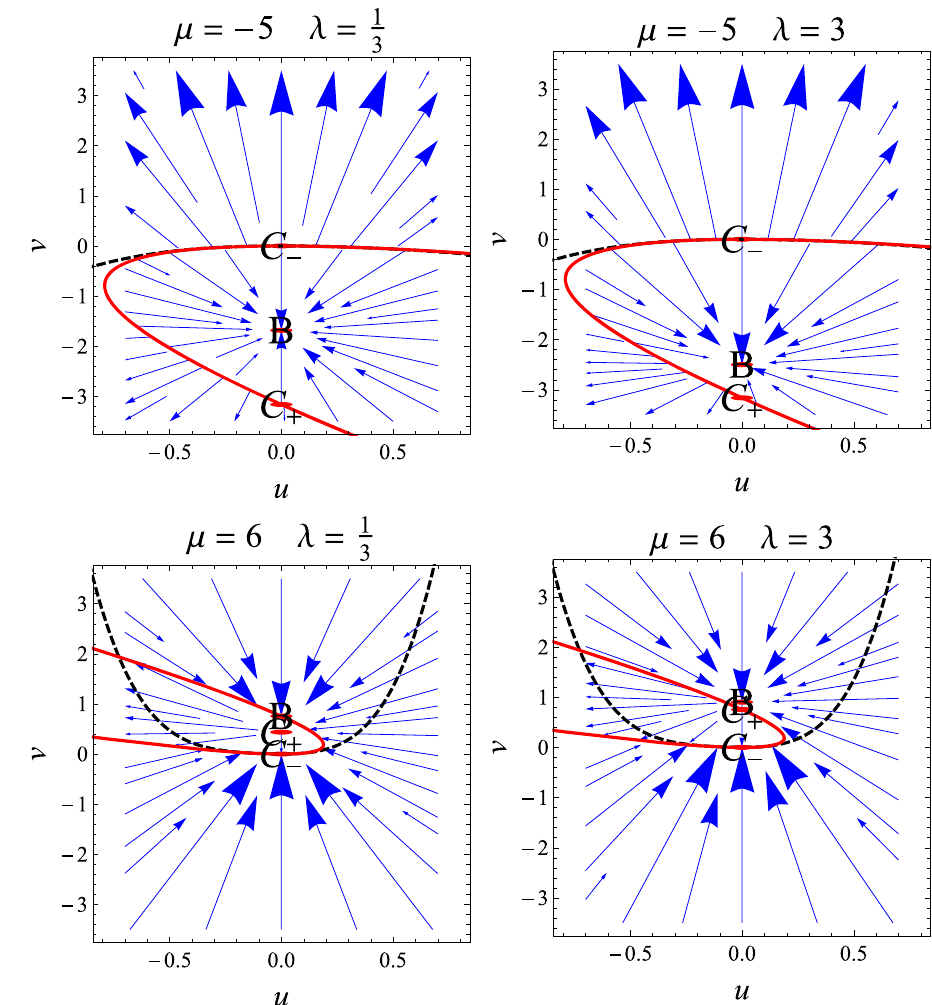
Fig. 6 Qualitative evolution in the phase plane ( u ,v) given by (45) for ω = 0. The solid red line denotes the implicit (cid:9) (cid:10) √ + x ( u )ω + function x ( u ) 6 y ( u ,v) 2 + 1 = 0, with x ( u ) and y ( u ,v) defined by (44) for ω = 0, whereas the dashed black lines represents the approximated center manifold of C + . Let us observe the accuracy for small